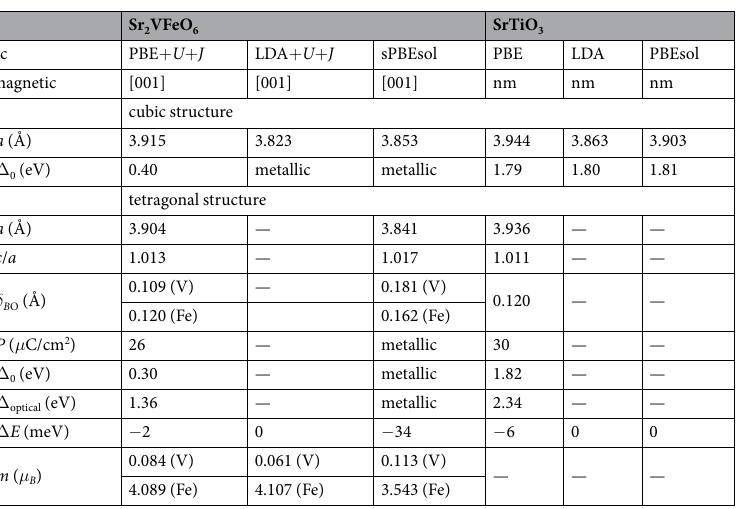
Table 3. Comparison of Sr 2 VFeO 6 and SrTiO 3 . The results are calculated using the DFT method with different exchange correlation functionals (xc). Antiferrodistortive modes are not taken into account in the calculations. ‘nm’ stands for non-magnetic and ‘[001]’ for the [001] antiferromagnetic ordering. For the cubic case, a is the lattice constant and Δ 0 is the fundamental gap. For the tetragonal case, a is the in-plane lattice constant, c / a is the ratio of out-of-plane lattice constant over in-plane lattice constant, δ B O is the B -site metal and oxygen displacement along the [001] direction. Δ 0 is the fundamental gap and Δ optical is the optical gap. Δ E is the energy difference between the tetragonal structure and the cubic structure in the unit of meV per 5-atom formula. P is the polarization along the [001] direction. m is the local magnetic moment on V and Fe